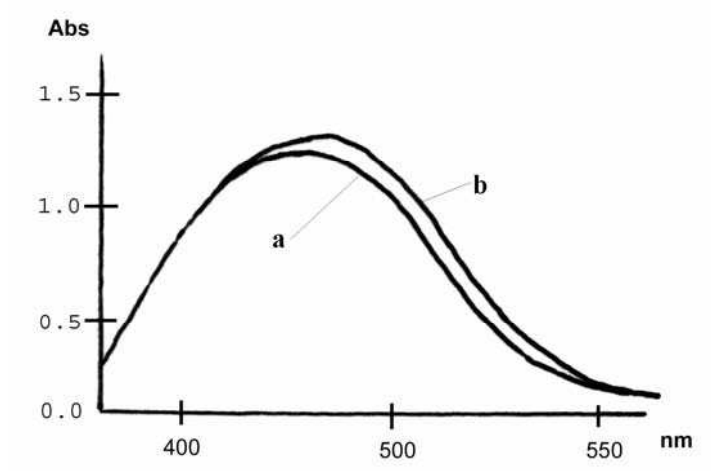
Fig. 4 UV-VIS spectrum of hydrazine: a – standard solution; b – hydrazine obtained from thermal decomposition of NH 3